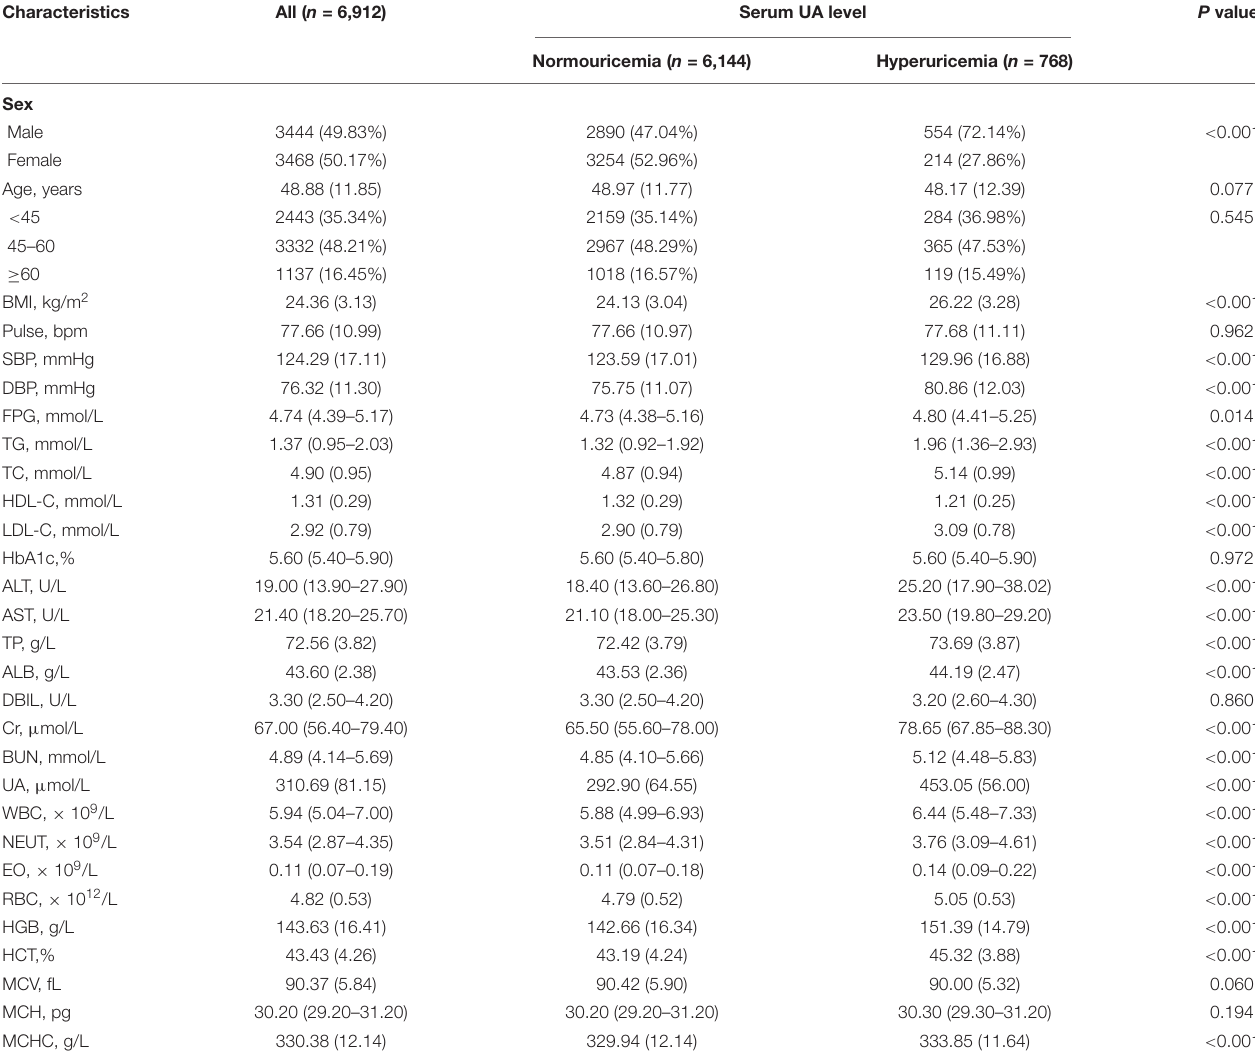
TABLE 1 | Baseline characteristics of the study population.